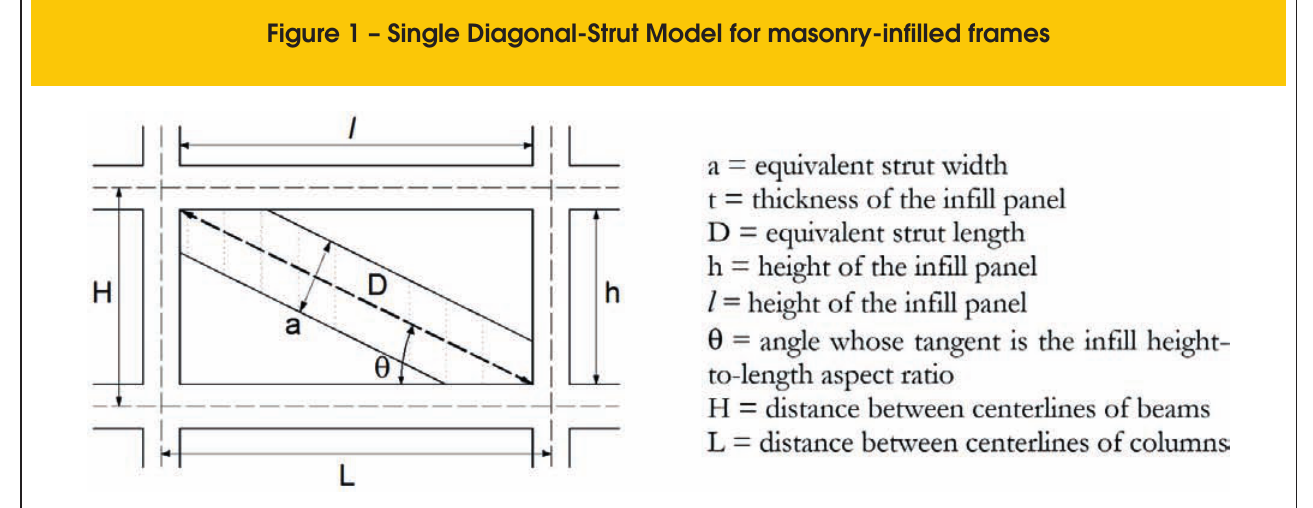
Figure 1 – Single Diagonal-Strut Model for masonry-infilled